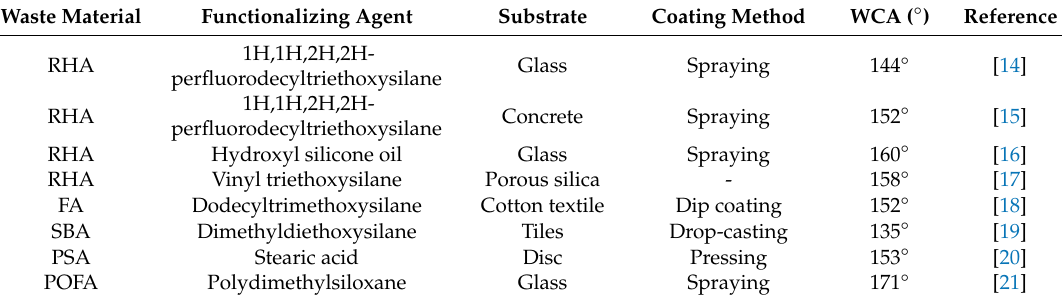
Table 1. A summary of sustainable waste materials used for super-hydrophobic